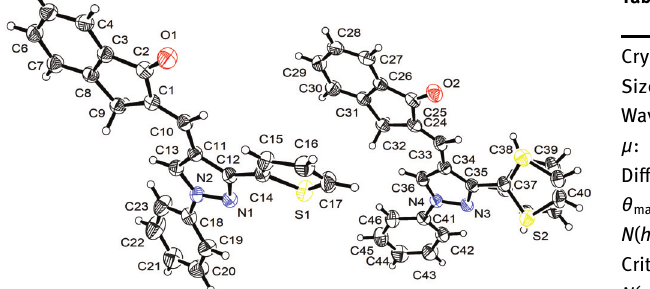
Table 1: Data collection and handling.